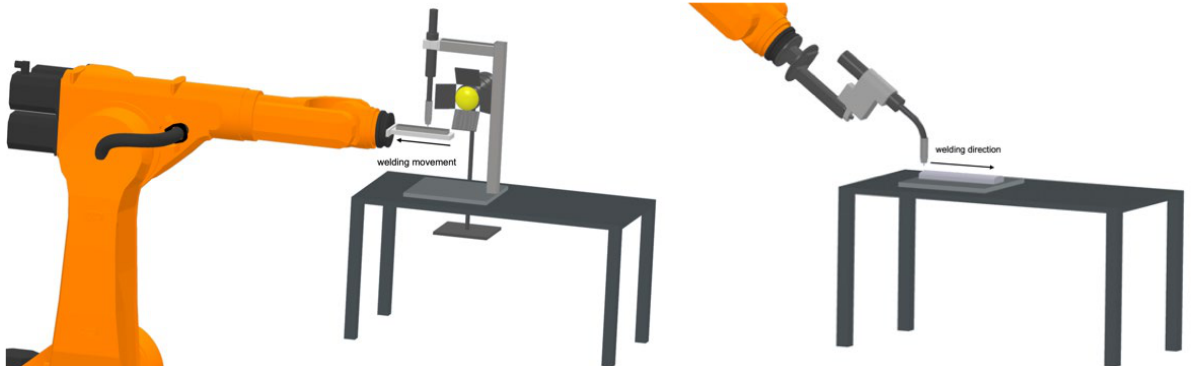
Figure 1. Test set-ups process and material property.